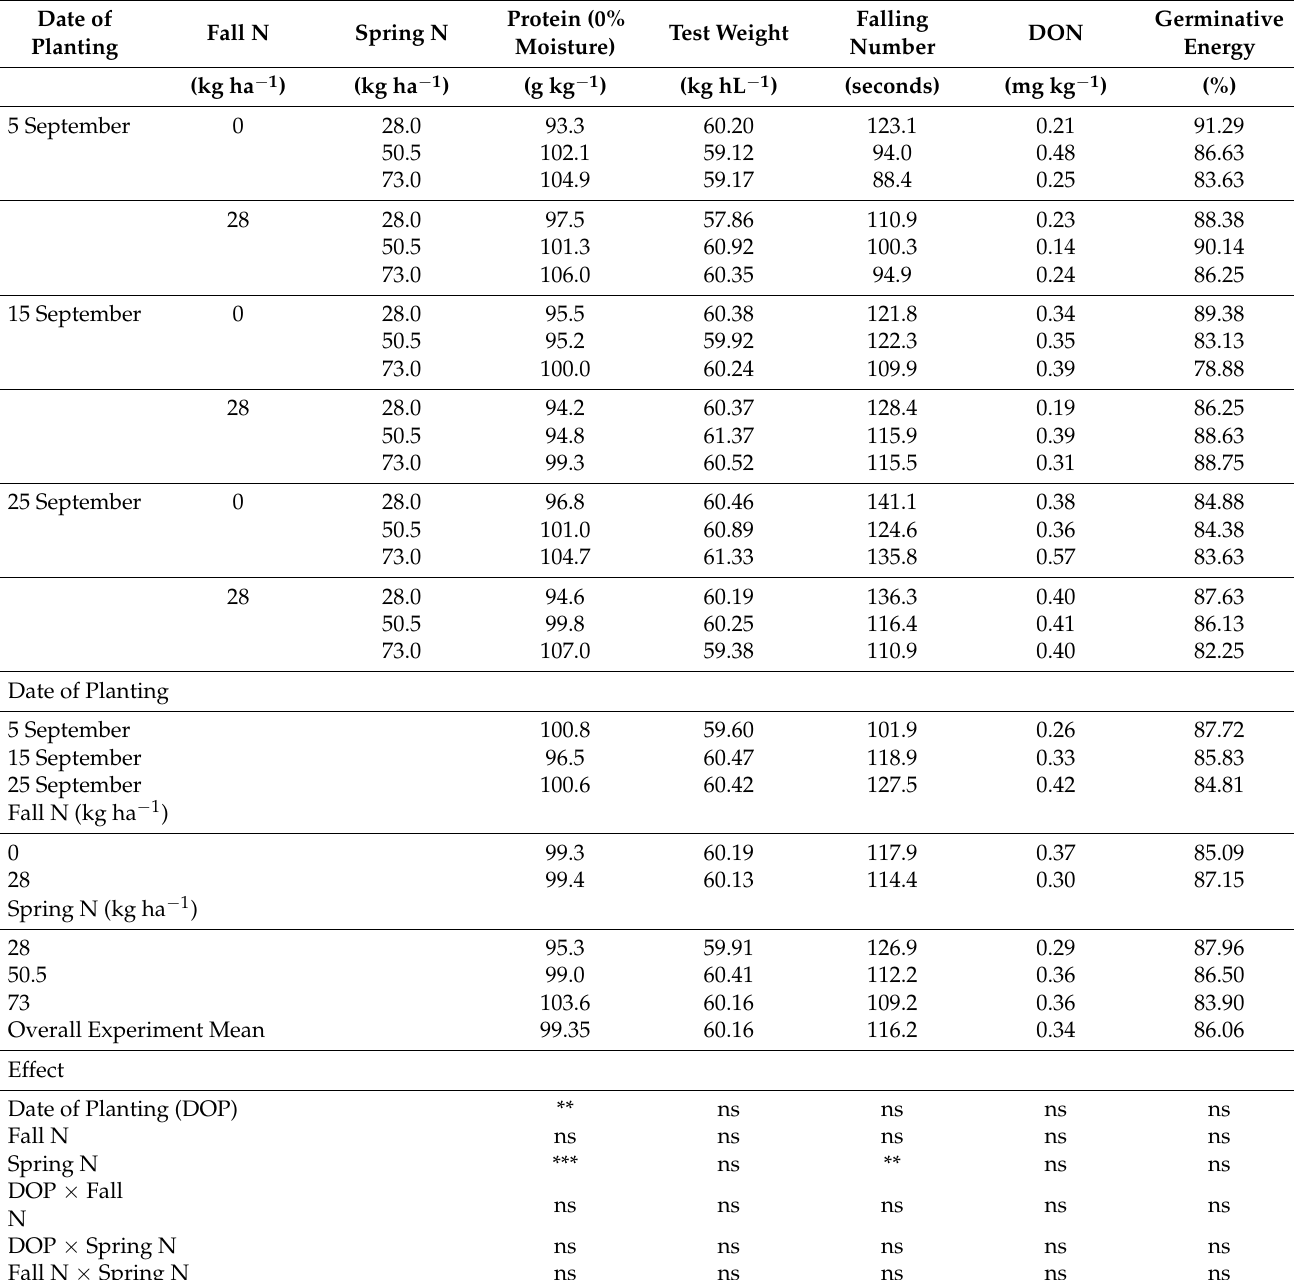
Table 3. Mean grain quality metrics for winter malt barley grown with different dates of planting and fall and spring N rates in South Deerfield MA in 2014–2015 and